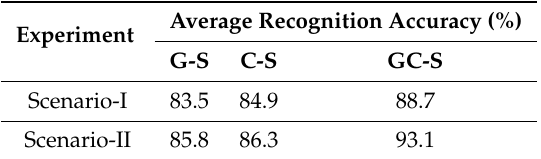
Figure 11. Comparison of accuracy for each activity with stand-alone features. Table 3. Comparison of GC-S with stand-alone G-S and C-S